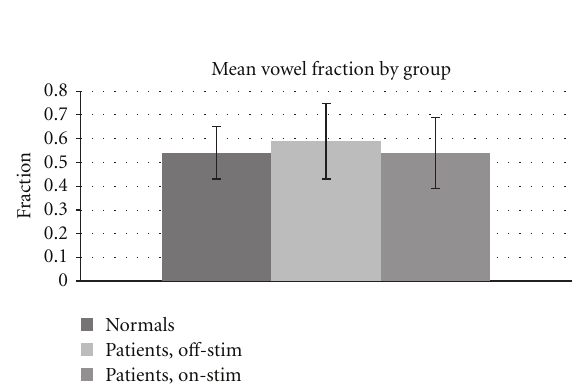
Figure 3: Mean vowel fraction across treatment condition. No comparisons